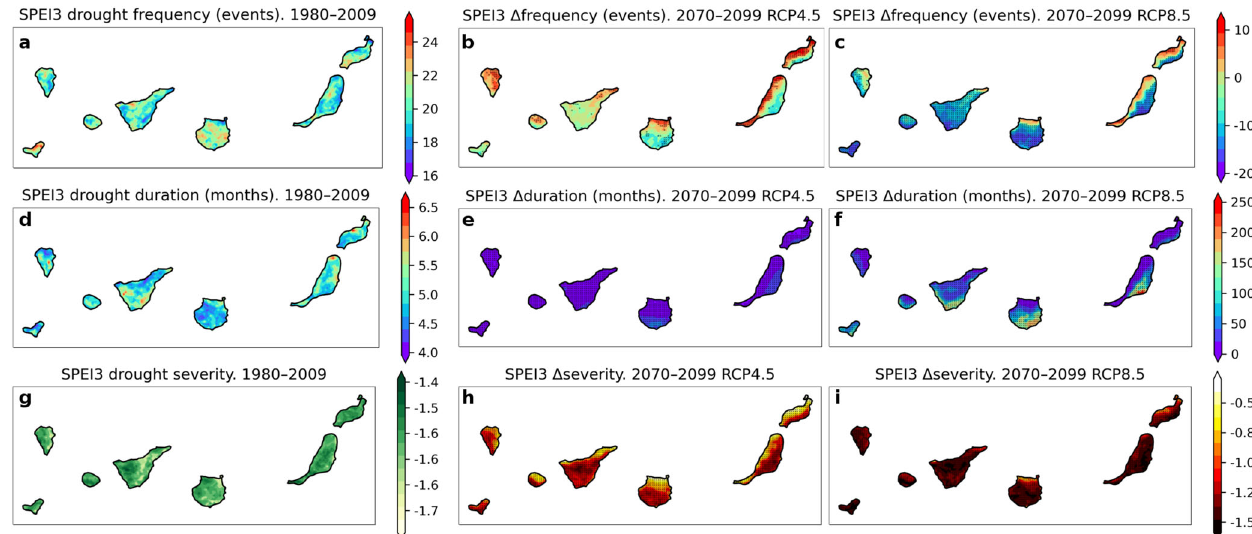
Fig. 6 Meteorological drought frequency, duration and severity in the recent past and their projected changes. Drought frequency (number of drought events in 30 years) ( a – c ), duration (months) ( d – f ), and severity (SPEI rating) ( g – i ) for the SPEI index computed at a 3-month time scale. Changes in the frequency, duration, and severity of drought events for the future (2070 – 2099), under RCP4.5 ( b , e , h ) and RCP8.5 ( c , f , i ), relative to the recent past period (1980 – 2009) ( a , d , g ). Duration and severity were obtained from values averaged for the entire period, whereas frequency is the number of events in 30 years. Dotted gridpoints correspond to robust future